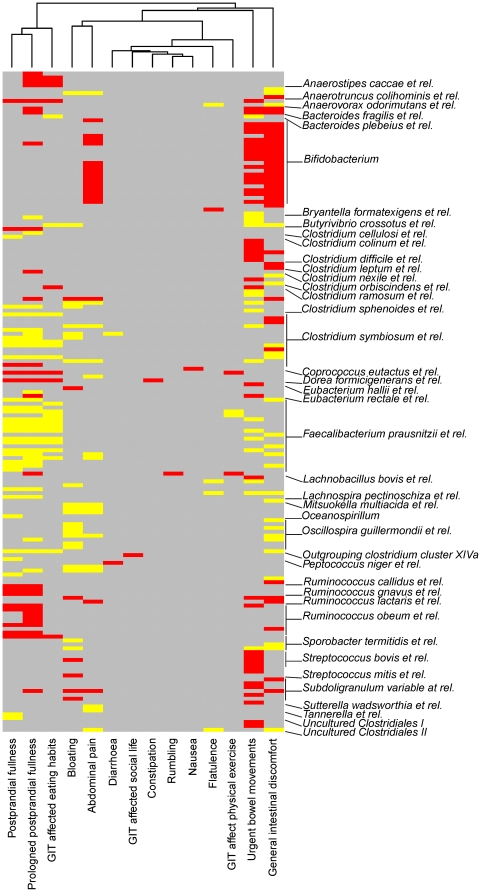
Correlation heatmap of the microbiota profiles and intestinal symptoms.The heatmap visualizes all significant (q-value <0.005) Spearman correlations between the intestinal symptoms and the HITChip-measured abundance of bacterial phylotypes. Each row represents a single phylotype, whose genus-level assignments are listed below the rows, or in the middle when several rows refer to the same genus-level group. The negative correlations between symptoms are indicated in red and the positive correlations with yellow; non-significant correlations are shown in gray.